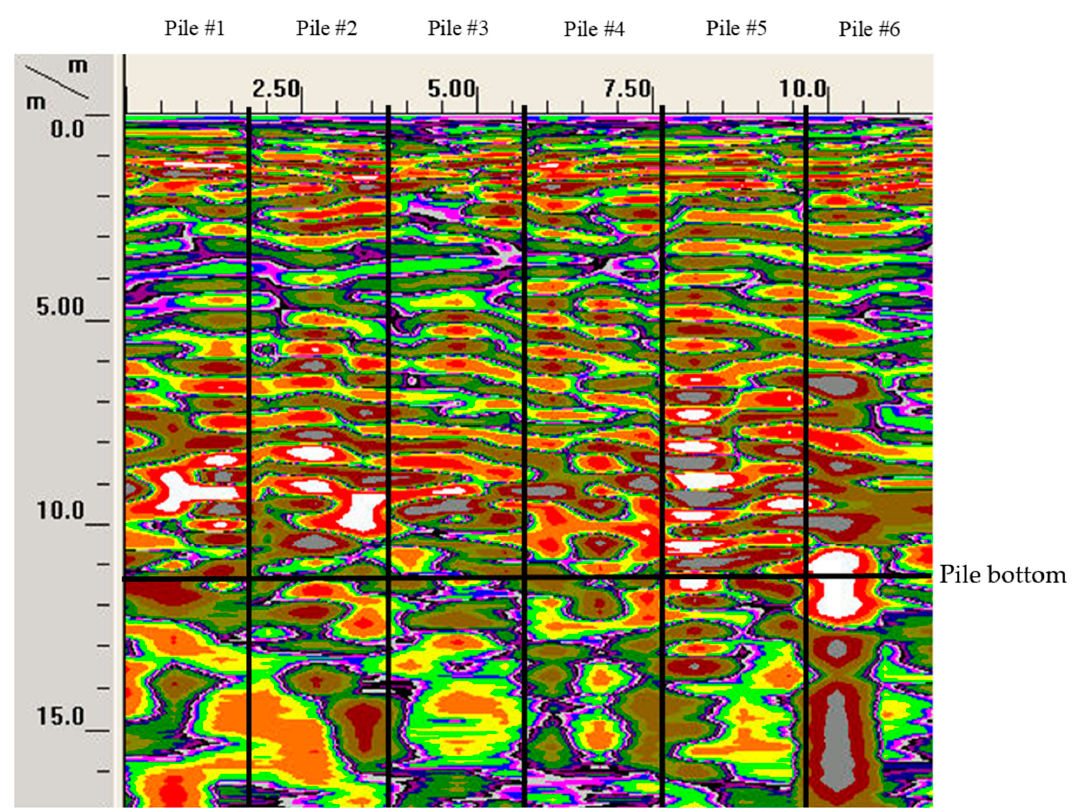
Figure 8. GPR image of 100 MHz (B-Scan).